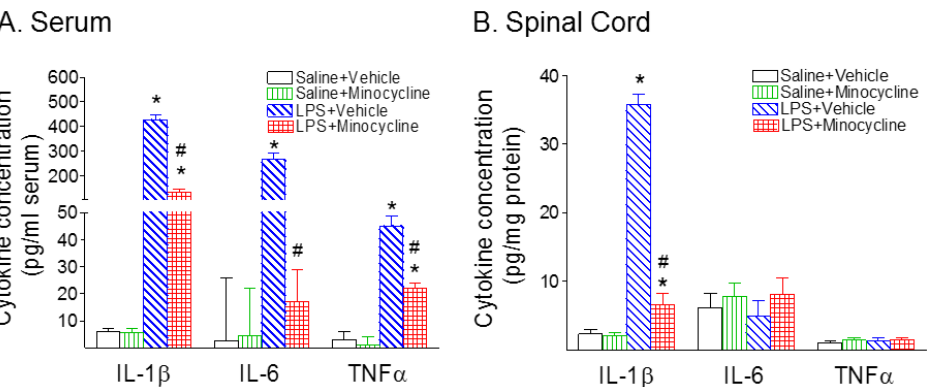
Figure 4. Minocycline attenuated systemic LPS exposure-induced increases in inflammatory cytokines (IL-1 β , interleukin-6 (IL-6), and tumor necrosis factor- α (TNF- α )) in the rat serum ( A ) and spinal cord ( B ) 24 h (P6) after LPS injection. ( A ), The concentration levels of IL-1 β , IL-6, and TNF- α 24 h (P6) following LPS injection in the serum were elevated compared with the control group. Minocycline attenuated an LPS-induced increase in the concentration levels of IL-1 β , IL-6, and TNF- α in the serum of P6 rats. ( B ), Following LPS injection, the concentration of IL-1 β in the spinal cord was elevated compared with the control group in the P6 rats. Minocycline attenuated LPS-induced increase in the concentration levels of IL-1 β in the spinal cord of P6 rats. The results are expressed as the mean ± SEM of eight animals in each group and analyzed by two-way ANOVA, followed by the Student–Newman–Keuls test. * p < 0.05 represents a significant difference for the LPS + Vehicle group, or LPS + Minocycline group compared with the Saline + Vehicle group. # p < 0.05 represents significant difference for the LPS + Minocycline group compared with the LPS + Vehicle group. ( n = 8).